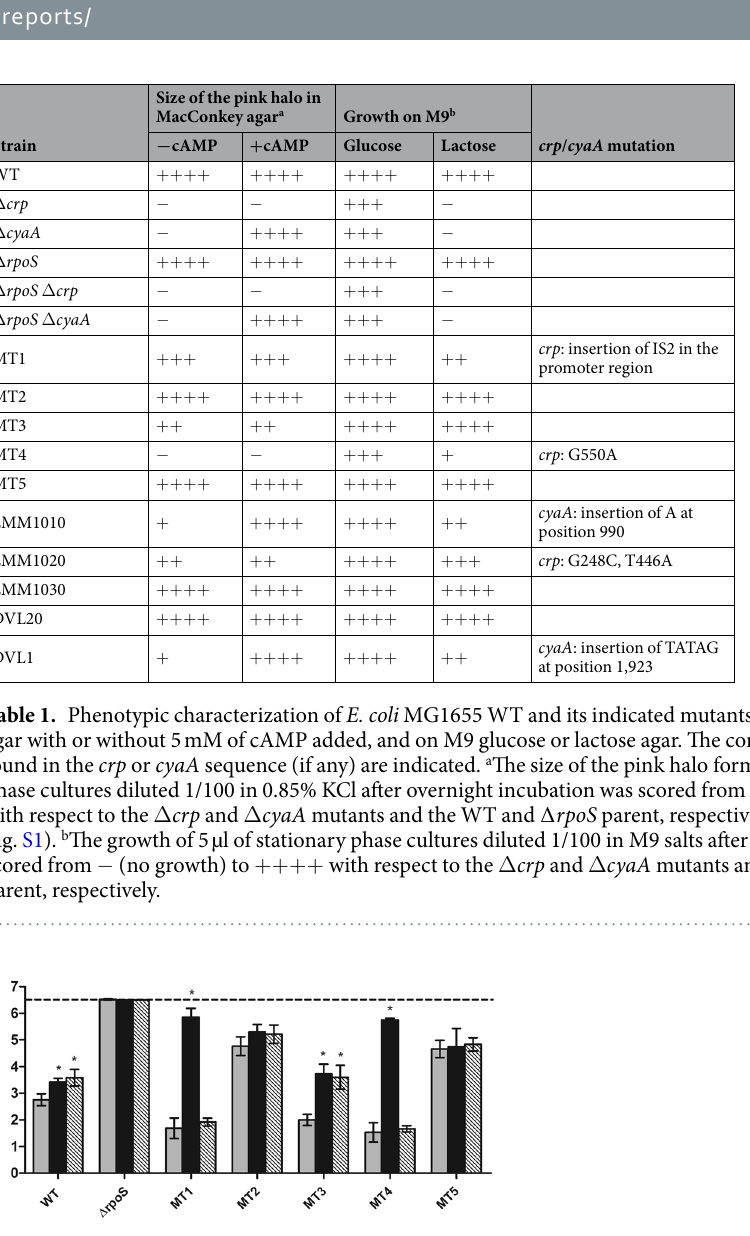
Figure 3. Logarithmic reduction factor of E. coli MG1655 WT, Δ rpoS and Δ rpoS evolved mutants equipped with pACYC184 (control vector; grey bars), pACYC184- crp (black bars) or pACYC184- cyaA (hatched bars) by a HHP treatment at 500 MPa for 15 min. The dotted line represents the quantification limit (1,000 CFU/ml). An asterisk indicates statistically significant differences ( P ≤ 0.05) between the inactivation of each strain equipped with pACYC184- crp or pACYC184- cyaA and the control